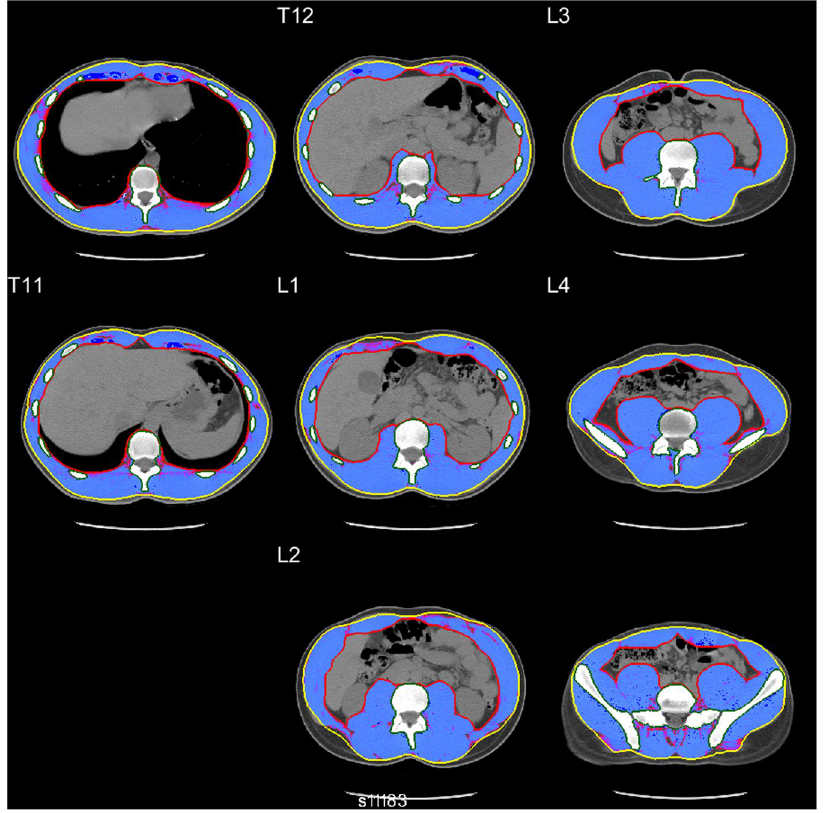
Figure 3. Example of healthy 20 y/o male T10-L5 axial CT slices showing SMA (blue-shaded area) between outer abdominal fascia (yellow line) and inner muscle wall (red